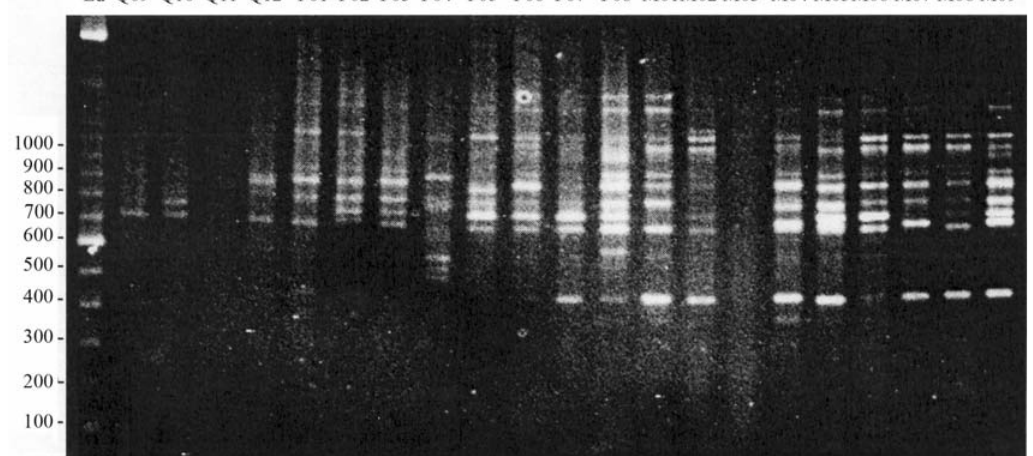
Figure 2 - Random amplified polymorphic DNA PCR patterns for the OPA13 primer in specimens of Eupemphix nattereri from three different munici- palities (Q = Quirinópolis; p = Palmeiras; and MO = Morrinhos). Ld = molecular weight